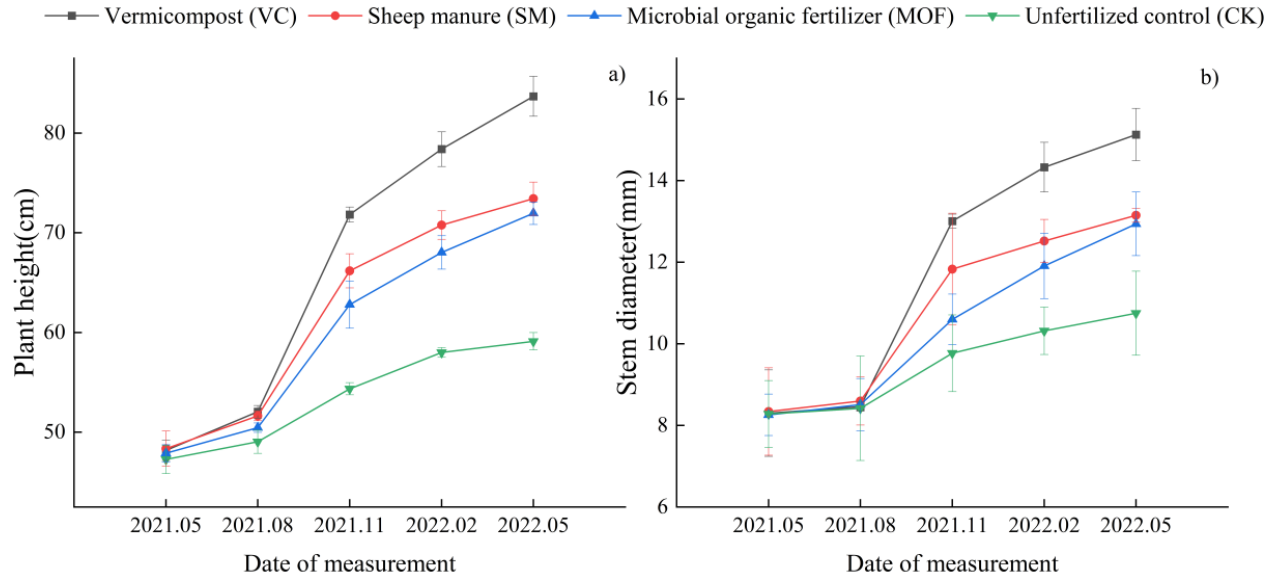
Figure 1. Growth rhythms of height and stem diameter of “Qi-Nan” agarwood seedlings under different bio-organic fertilizer treatments. ( a ) plant height; ( b ) stem diameter. No fertilizer (CK); vermicompost (VC); sheep manure (SM); microbial organic fertilizer (MOF). The bars are means ± standard error .